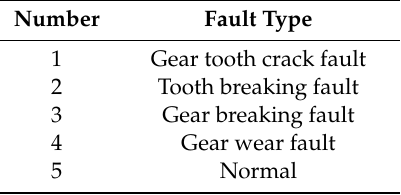
Table 4. Corresponding information between number and fault type.